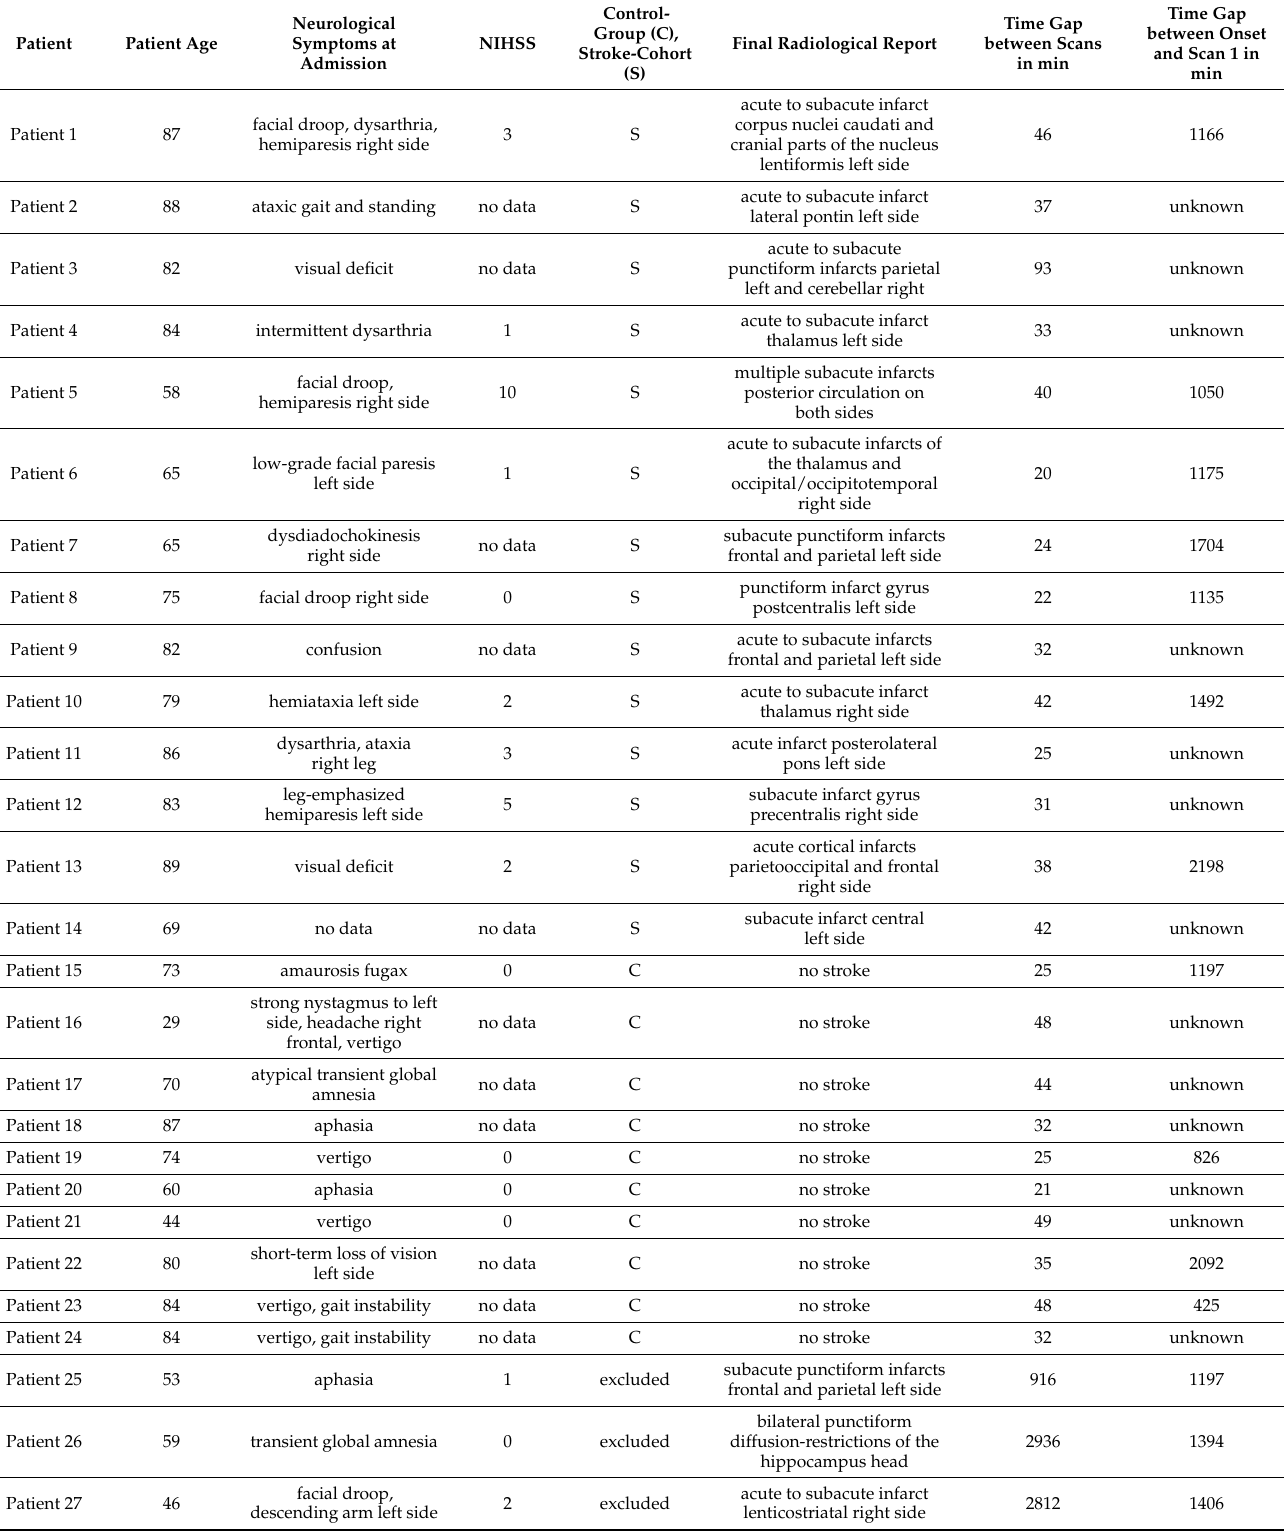
Table 2. Detailed patient